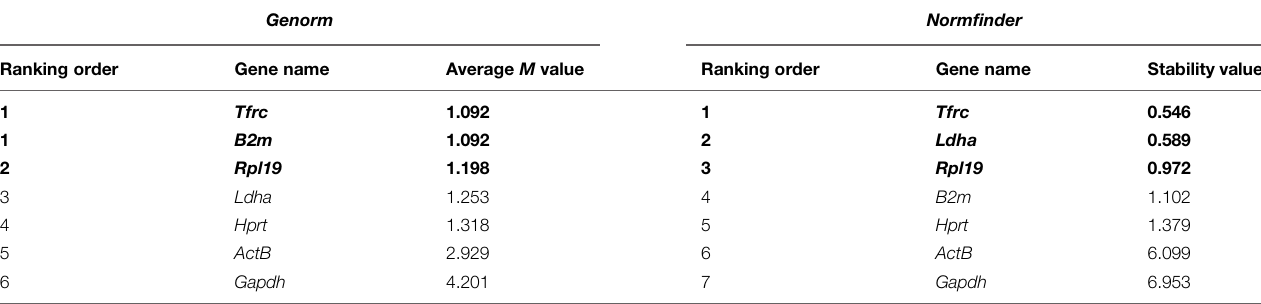
TABLE 6 | Candidate housekeeping genes ranked in cerebellar granule neurons treated with CSF of MS/NMO patients according to their expression stability by Genorm and Normfinder